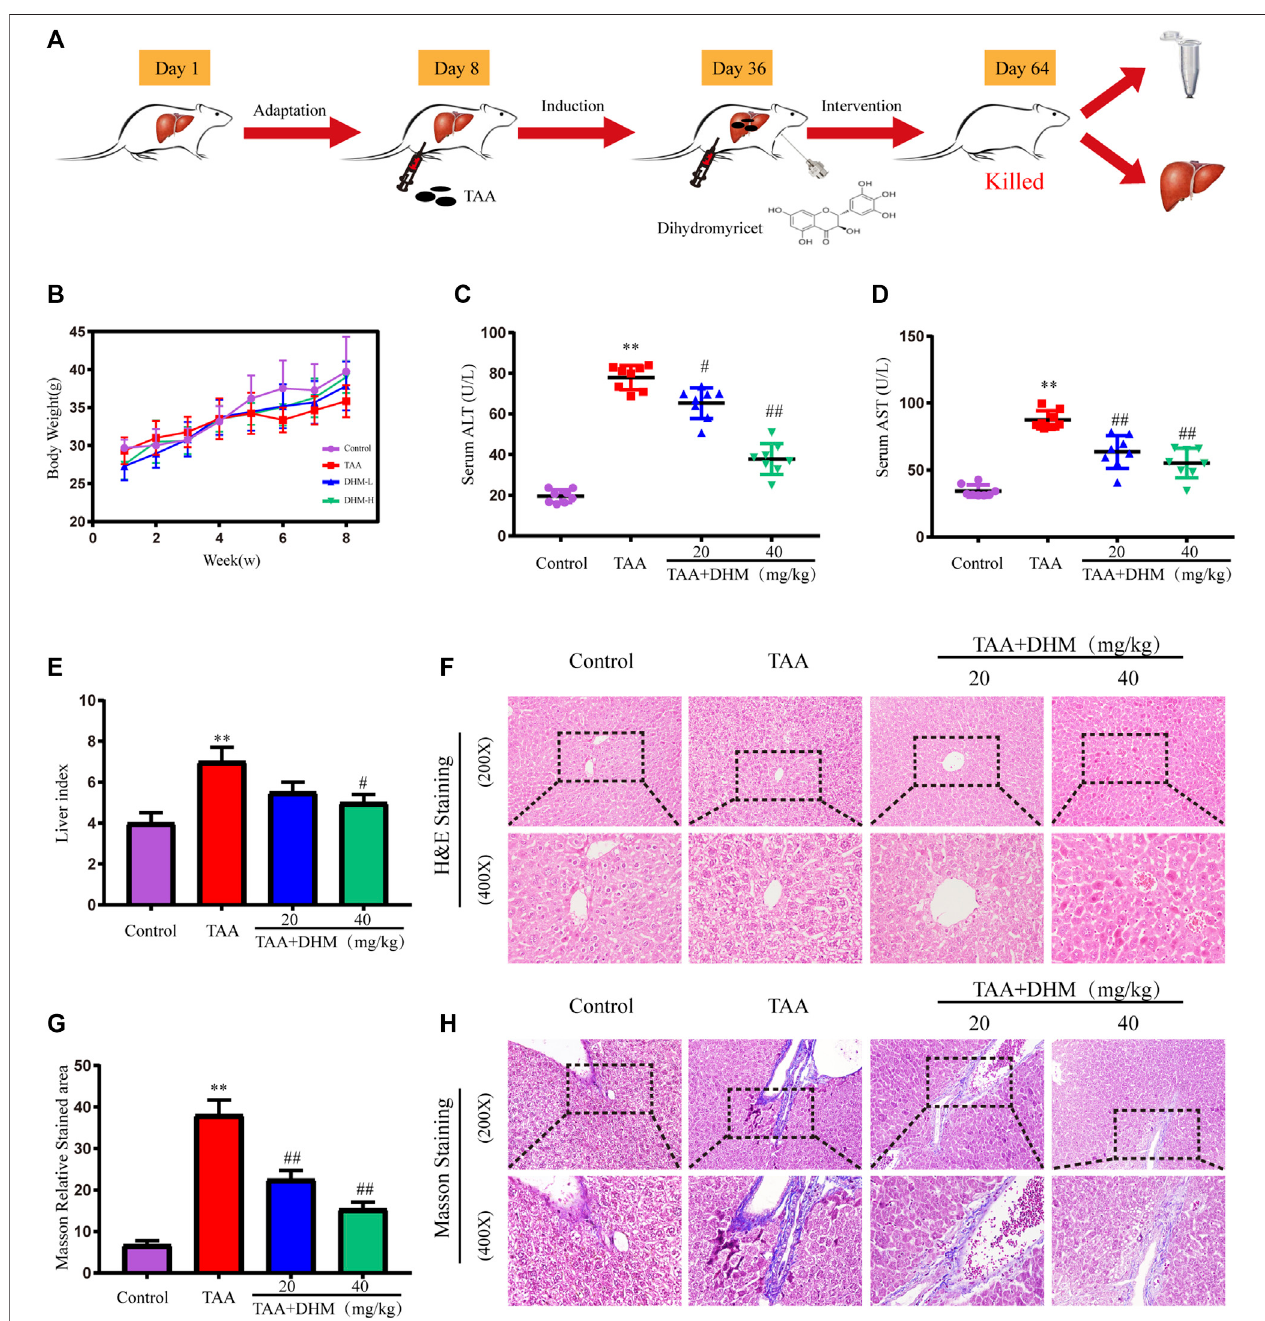
FIGURE 1 | DHM ameliorated TAA-induced hepatic injury in mice. The experimental design (A) ; Body weight (B) and serum levels of ALT (C) and AST (D) ( n (cid:1) 8); liver index (E) , H&E staining (F) ; Masson relative stained area (G) and Masson ’ strichrome staining (H) ; Data was expressed as the mean ± SD. The differences between groupswereanalyzedbytwotailedT-testorone-wayanalysisofvariance(ANOVA).** p < 0.01,* p < 0.05 versus controlgroup;## p < 0.01,# p < 0.05 versus TAAgroup.